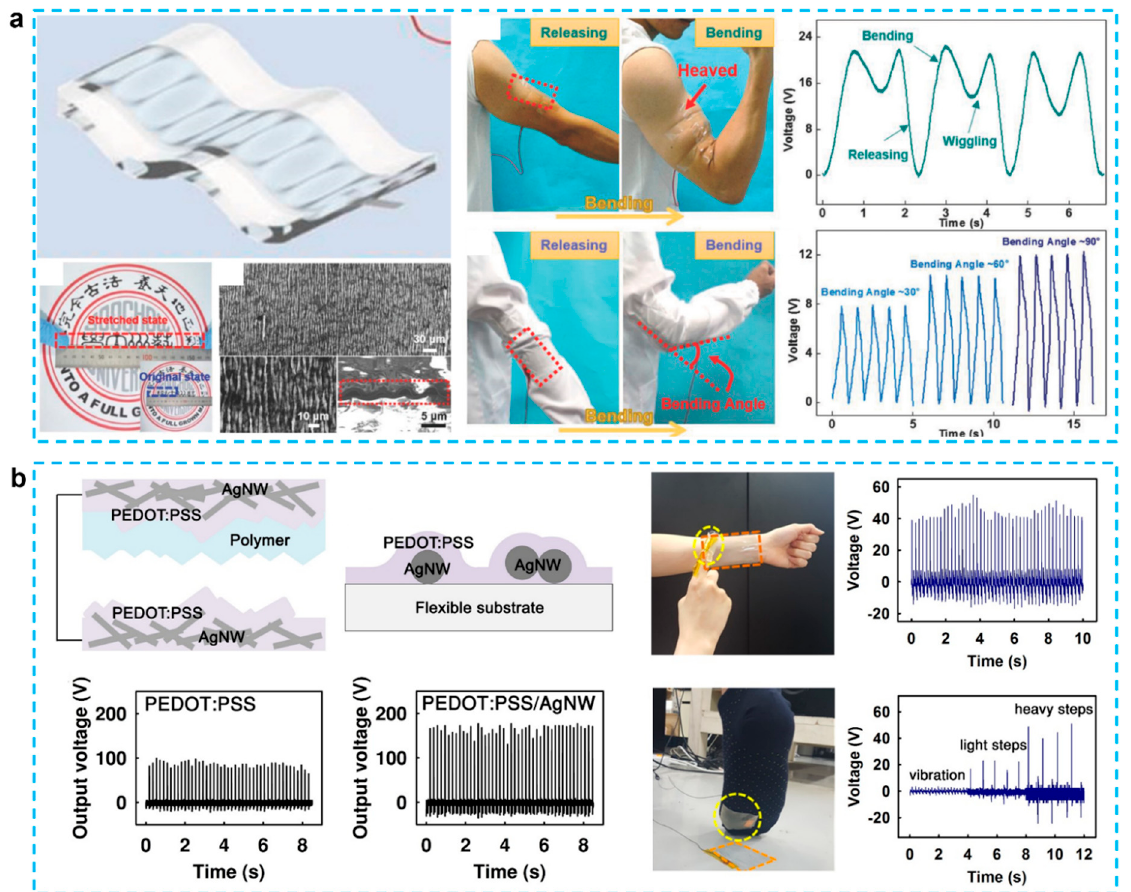
Figure 8. ( a ) A wrinkled PEDOT:PSS film-based stretchable and transparent triboelectric nanogenerator for wearable energy harvesters and active motion sensors [107]. ( b ) Transparent and flexible high power triboelectric nanogenerator with metallic nanowire-embedded tribonegative conducting polymer [101].